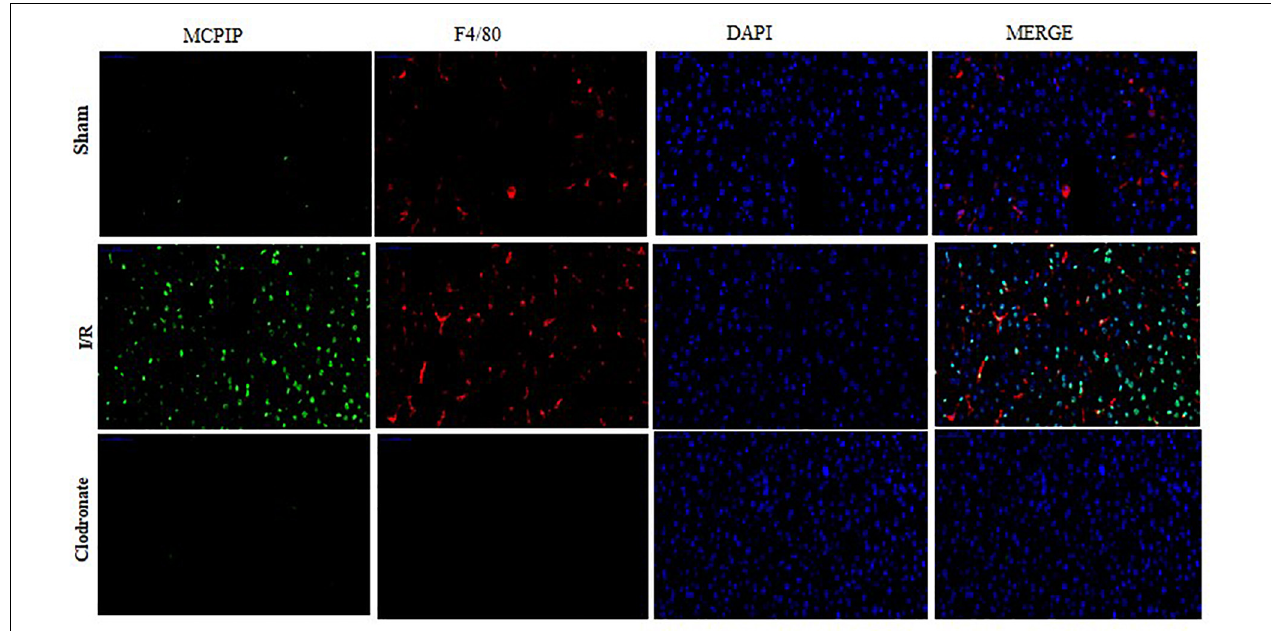
FIGURE 3 | Double immunofluorescence staining was conducted to assess the expression and localization of MCPIP among Kupffer cells (KCs). MCPIP was stained green, KCs were stained with F4/80 (red), cell nuclei stained with DAPI (blue), and MCPIP (green). There were still a few luminous spots of MCPIP (green) upon macrophage exhaustion, which might support its various provenances, such as monocytes and